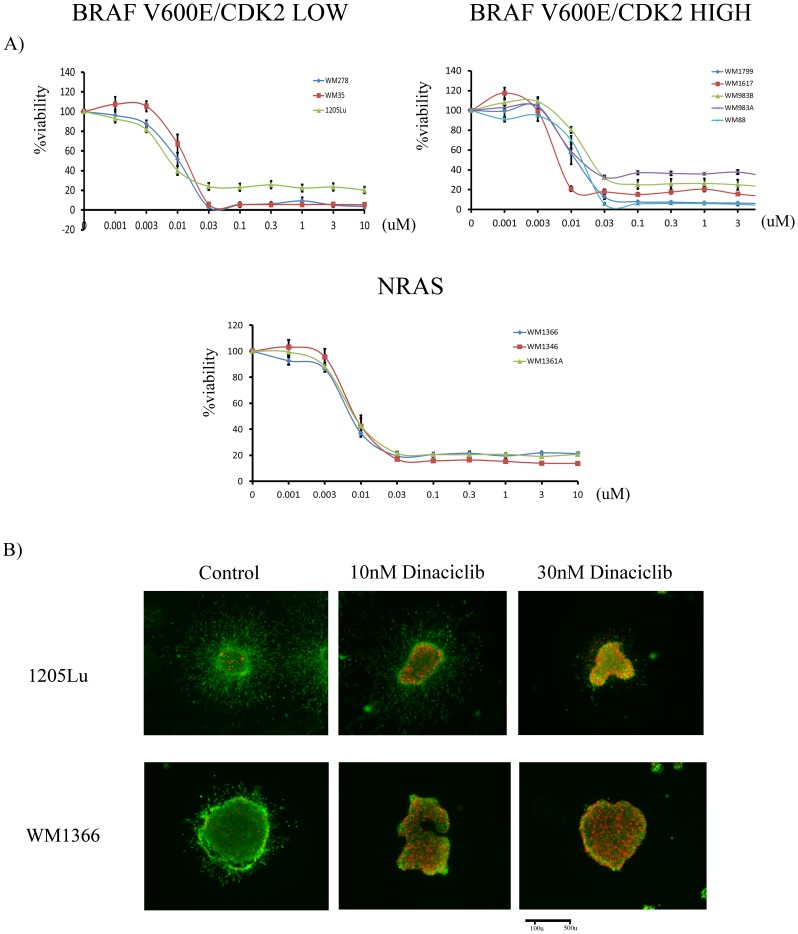
Dinaciclib inhibits the growth and survival of melanoma cell lines grown under both 2D adherent culture and 3D organotypic cell culture conditions.A) Growth inhibition for melanoma cells treated with dinaciclib measured by the MTT assay. Cells were treated with increasing concentrations of dinaciclib (1 nM–10 µM) for 72 hours before treatment with the MTT reagent. Absorbances were read at 570 nm and expressed as a percentage of control. B) Dinaciclib reduces the viability and invasion of melanoma cells grown as three-dimensional collagen-implanted spheroids. Preformed melanoma spheroids that harbored either the BRAF V600E mutation (1205Lu) or NRAS mutation (WM1366) were embedded into collagen and overlaid with medium. Cells were then treated with either 10 nM or 30 nM dinaciclib for 72 hours before being stained with calcein-AM and ethidium bromide. Spheroids were visualized and photographed using an inverted fluoresce microscope. Green, viable cells; red, dead cells.